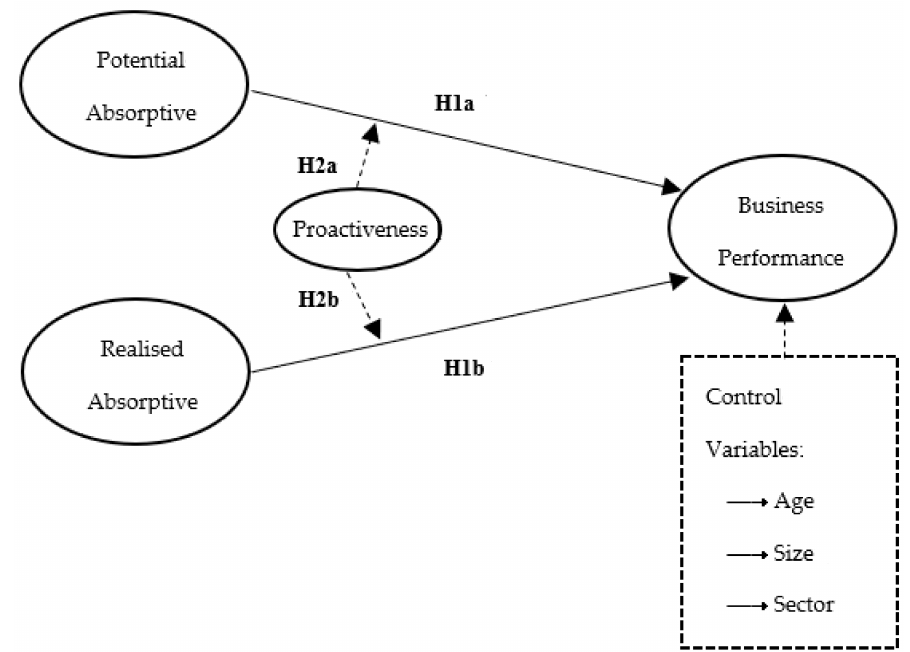
Figure 1. Theoretical